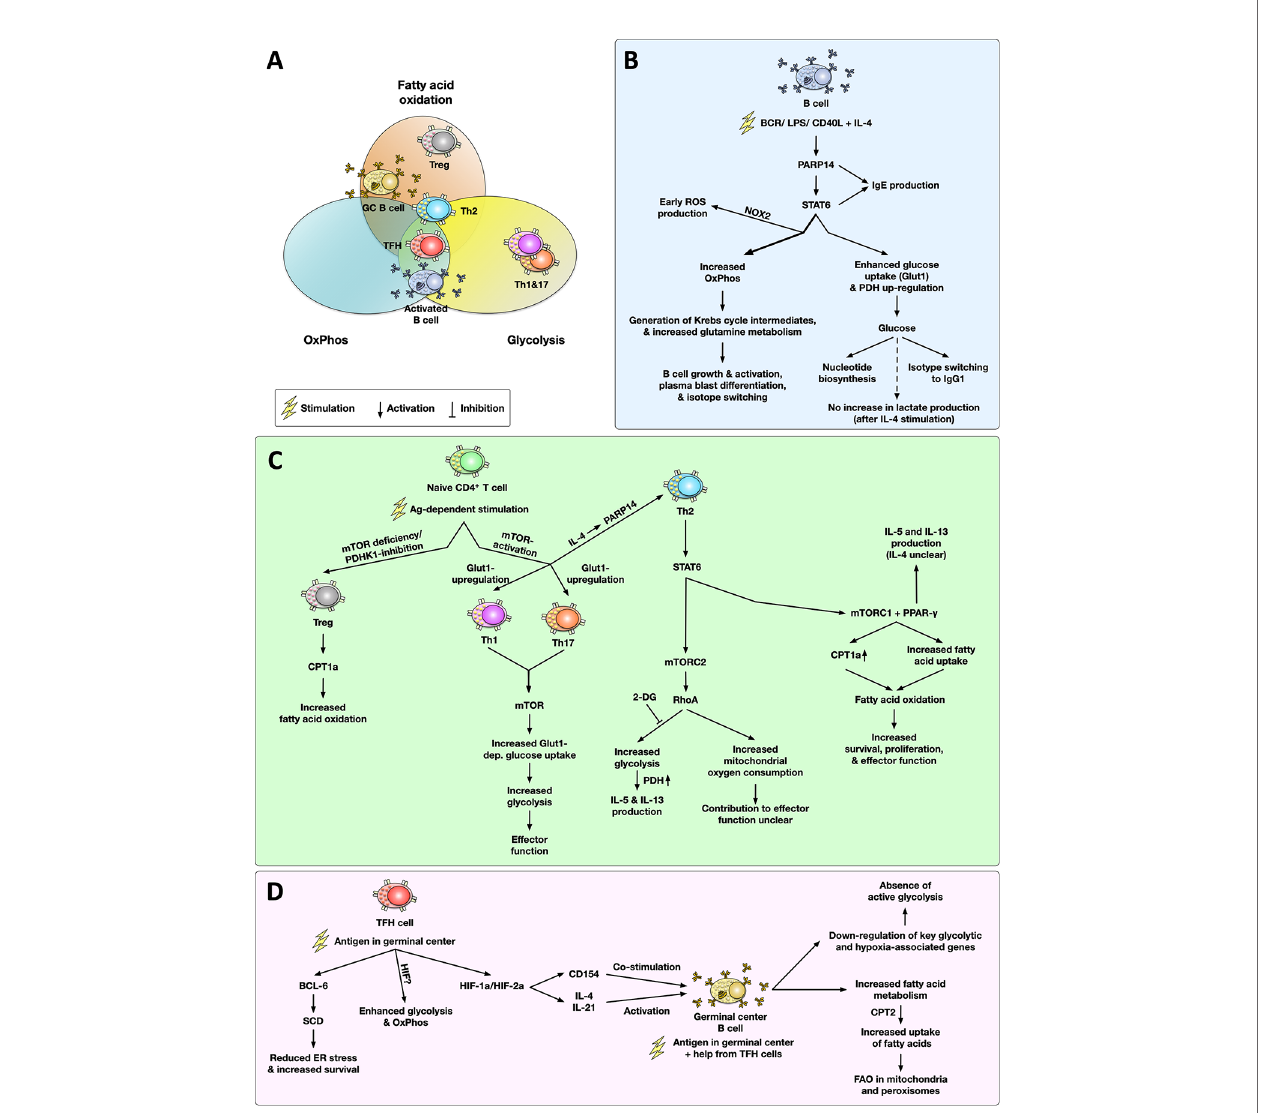
FIGURE 2 | Metabolic phenotype and main signaling pathways associated with the activation of T and B cells in allergies. Cell types are grouped within the metabolic pathways (glycolysis, oxidative phosphorylation (OxPhos), fatty acid oxidation (FAO)) according to the published and discussed literature (A) . Upon activation, IL-4-stimulated B cells undergo complex metabolic changes, including a poly ADP-ribose polymerase 14 (PARP14)-dependent increase in glucose consumption driving both nucleotide synthesis and IgG1 production as well as high rates of OxPhos and glutamine metabolism, which promote B cell activation, plasmablast differentiation, and isotype switching (B) . In naïve CD4 + T cells antigen-dependent stimulation results in a mechanistic target of rapamycin (mTOR)- dependent T helper cell differentiation. While inhibition of mTOR results in differentiation of regulatory T cells (Treg) with a predominant carnitine palmitoyl transferase 1a (CPT1a)-dependent increase in FAO, mTOR activation is critically important for either Th1, Th2, Th17 differentiation. In both Th1 and Th17 cells, mTOR activation drives a glycolytic phenotype. In Th2 cells, mTOR complex 2 (mTORC2) promotes a RhoA-dependent increase in glycolysis (which was shown to contribute to IL-5 and IL-13 production) and an increase in mitochondrial oxygen consumption (whose contribution to Th2 effector function is currently unclear). Moreover, activation of mTORC1 and peroxisome proliferator-activated receptor gamma (PPAR- g ) in Th2 cells promotes fatty acid uptake and oxidation which fuels Th2 cell survival, proliferation, and effector function (C) . In germinal centers (GC), follicular T helper cells (TFH) HIF-1/2a-dependently promote the activation of germinal center B cells via CD154- dependent co-stimulation and the production of the switching cytokines IL-4 and IL-21 (D) . Here, TFH cells display both enhanced glycolysis and OxPhos while using the lipid metabolism enzyme stearoyl-CoA desaturase (SCD) to reduce ER stress and increase survival. In contrast to other cells types, antigen-activated GC B cells mainly rely on FAO for energy generation while suppressing glycolytic genes. For more detailed information see text. OxPhos, oxidative phosphorylation; FAO, fatty acid oxidation; BCR, B cell receptor; LPS, lipopolysaccharide; Glut1, glucose transporter 1; TCR, T cell receptor; 2-DG, 2-deoxy glucose; mTOR(C1/2), mechanistic target of rapamycin complex 1/2; PDH(K1), pyruvate dehydrogenase (kinase 1); LDH, lactate dehydrogenase; Treg, regulatory T cell; CPT1a/2, carnitine palmitoyl transferase 1a/2; PARP14, Poly ADP-ribose polymerase 14; PPAR- g , peroxisome proliferator-activated receptor gamma; ROS, reactive oxygen species; STAT6, signal transducer and activator of transcription 6; NOX2, NADPH oxidase 2; BCL-6, B-cell lymphoma 6 protein; GC, germinal center; TFH cell, follicular T helper cell; SCD, stearoyl-CoA desaturase; HIF-1/2a, hypoxia inducible factor